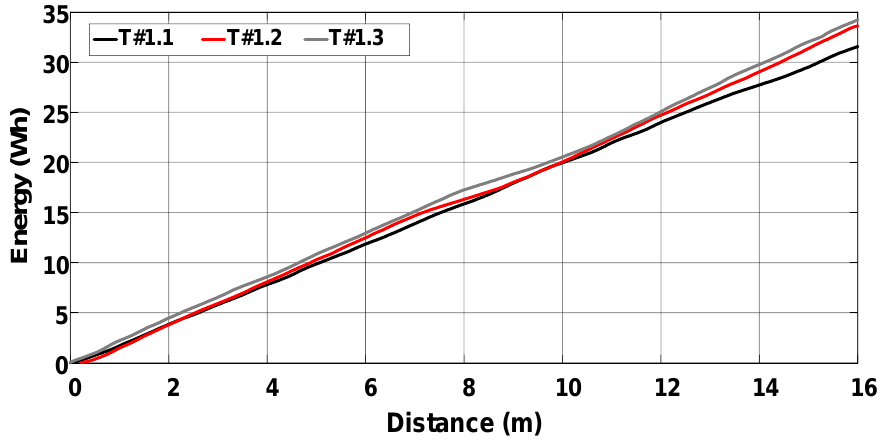
Figure 19. Energy consumption during the trial sessions carried out on firm soil and without slip